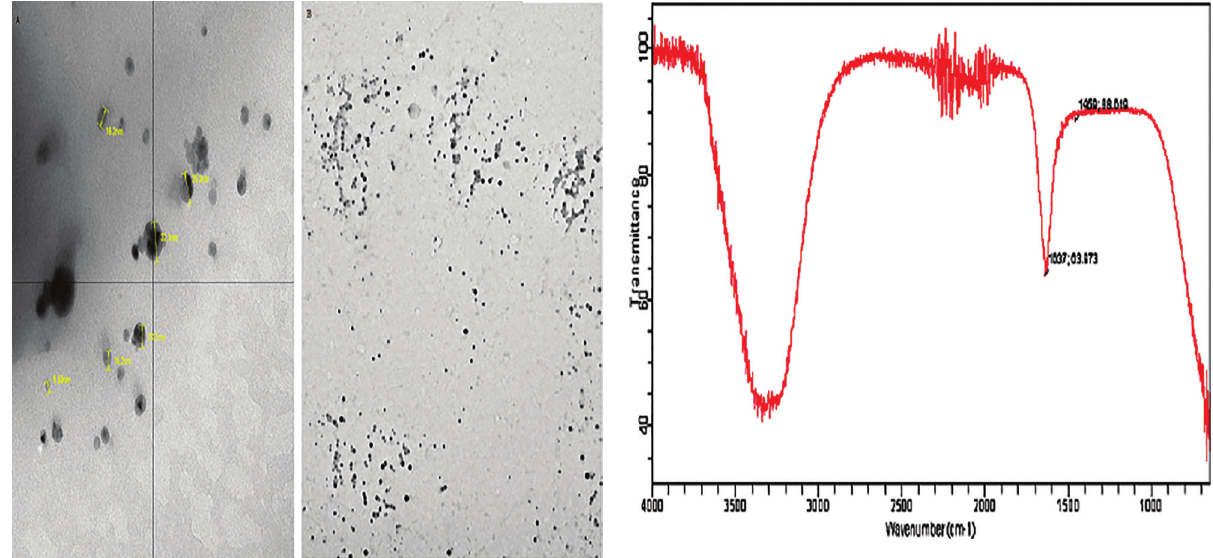
Figure 3: FTIR spectrum of bacterial